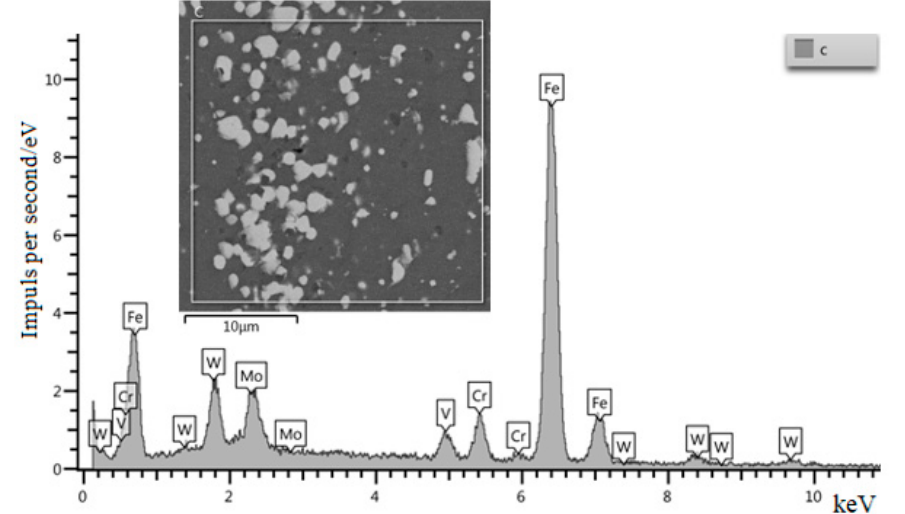
Materials 2022 , 15 , x FOR PEER REVIEW Figure 8. Qualitative analysis of the initial W6Mo5Cr4V2 steel (without dynamic treatment).